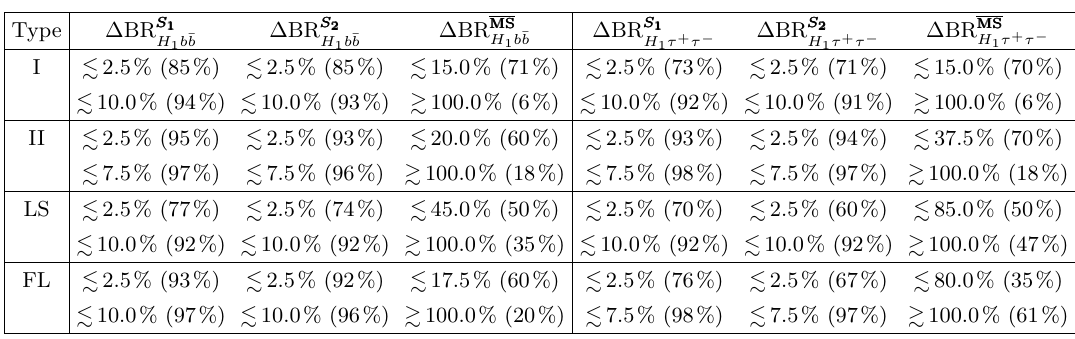
Table 22 . Relative size of the EW corrections to the BRs of the non-SM-like N2HDM Higgs boson H 1 into b (cid:22) b and (cid:28) + (cid:28) (cid:0) , for the four N2HDM types I, II, LS and FL ( H 2 is SM-like). small LO BRs (see next item) or parametrically enhanced corrections. This again indirectly a(cid:11)ects through the total width the decay channels with typically more moderate corrections, inducing more signi(cid:12)cant (cid:1)BR